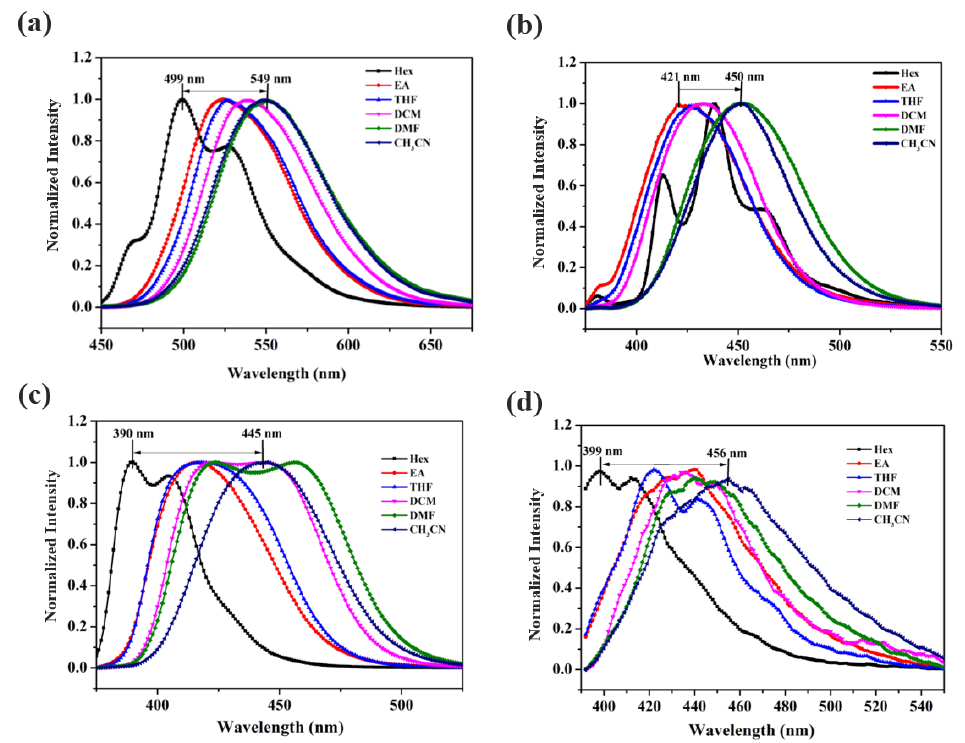
Figure 1. Normalized PL spectra of ( a ) PI , ( b ) NI , ( c ) TI , ( d ) FI in various solvents (5 × 10 − 5 M). λ ex = 365 nm.